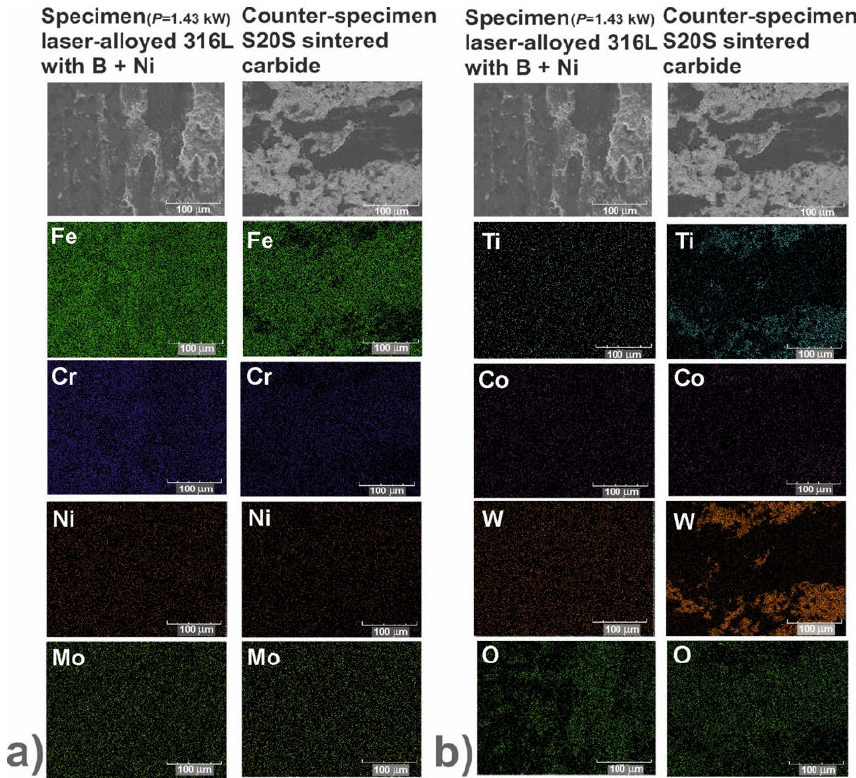
Figure 11. Worn surfaces of laser-alloyed specimen with boron and nickel using a dilution ratio of 0.42 ( P = 1.43 kW) and counter-specimen (S20S sintered carbide). ( a ) EDS patterns of the elements characteristic of the specimen as well as ( b ) the counter-specimen, taking into account oxygen concentration. Two-hour wear test with the change of counter-specimen at every 0.5